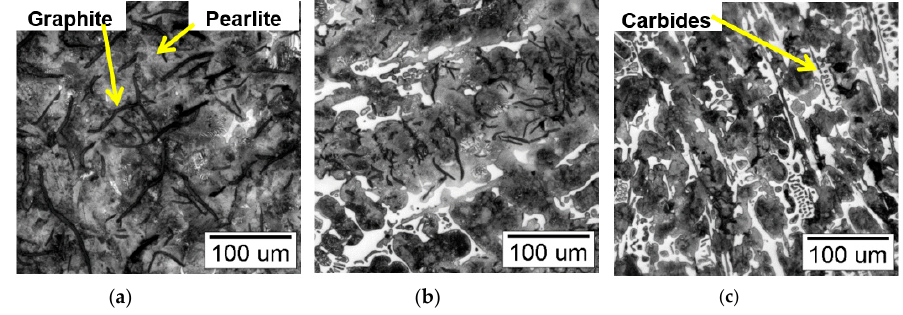
Figure 1. Typical structure of grey cast iron ( a ), <2% carbides and mottled cast irons, ( b ) 8% carbides; ( c ) 20% carbides.